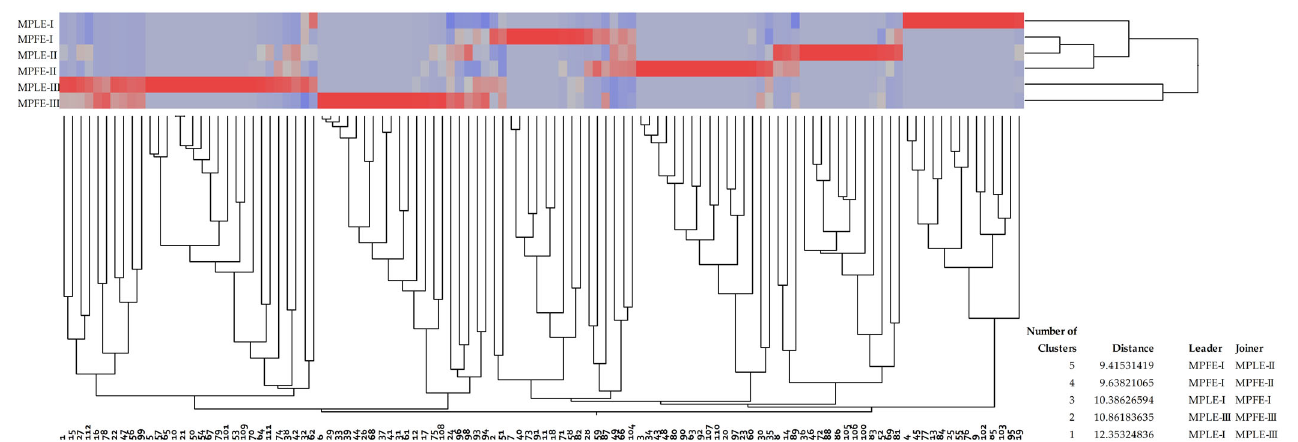
Figure 5. Agglomerative hierarchical clustering analysis of MPLE and MPFE phytochemical